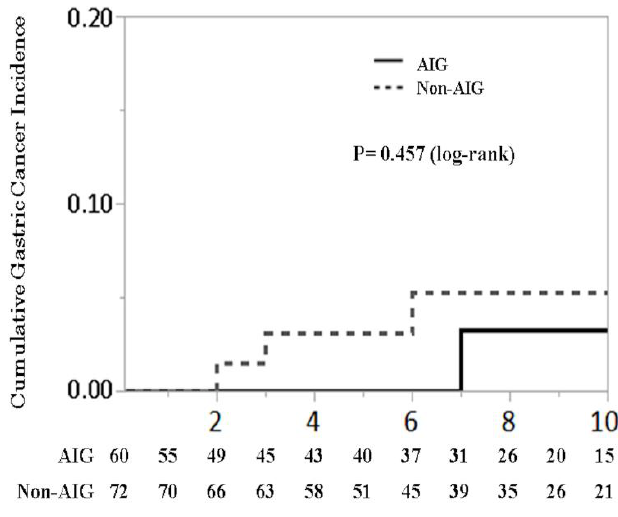
Figure 4. Cumulative gastric cancer incidence.